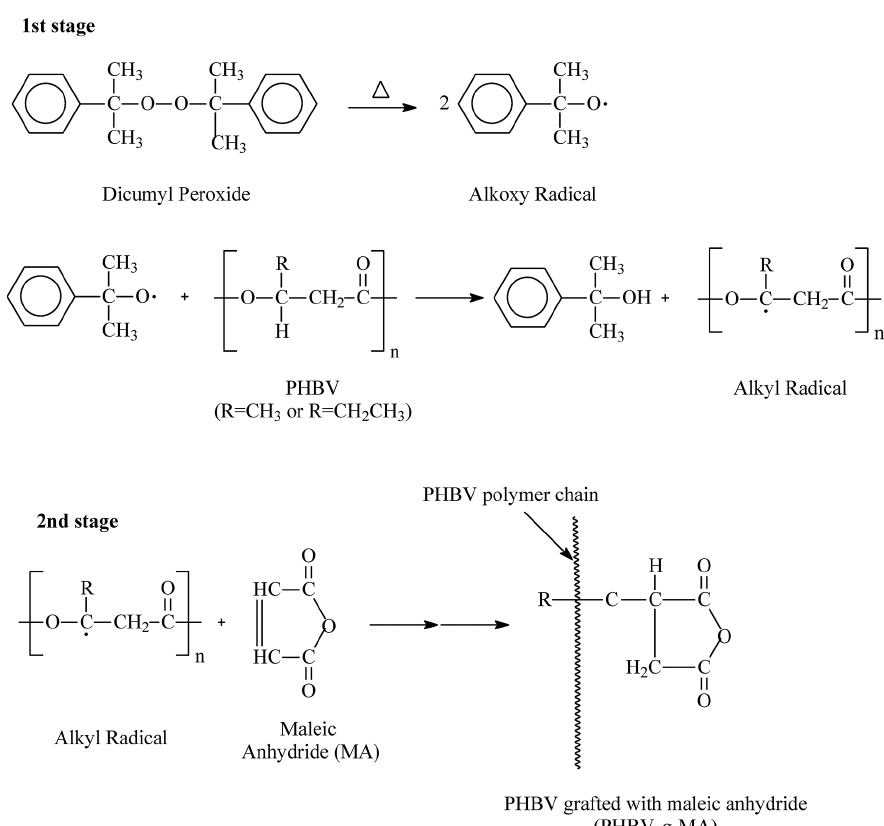
Figure 1. Reaction scheme of grafting reactions between MA and PHBV in presence of